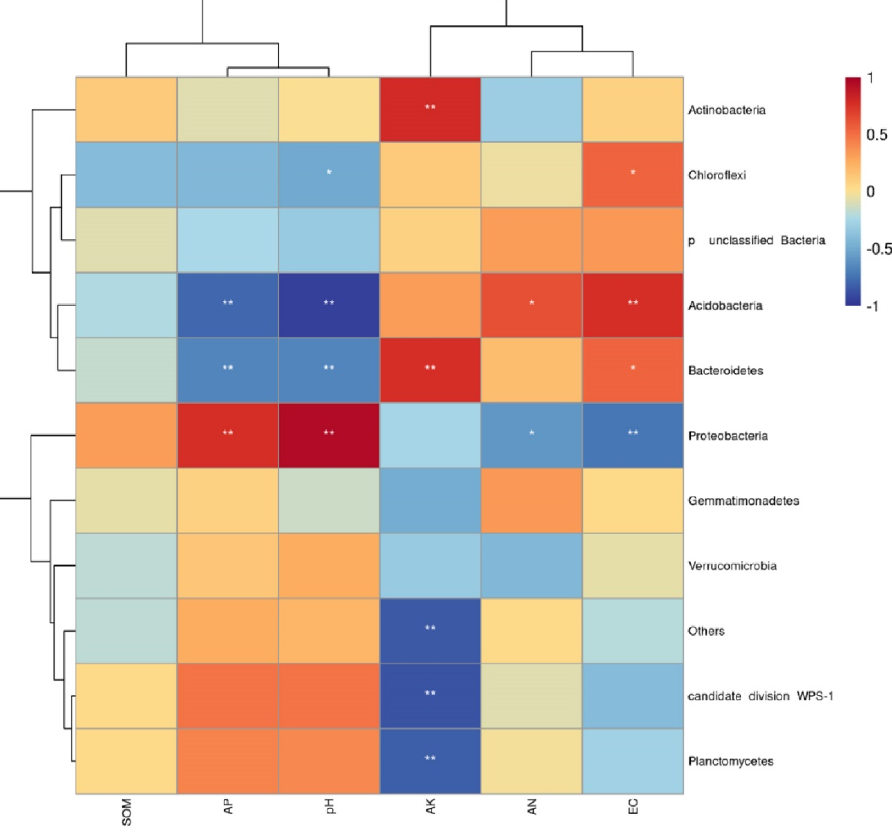
Figure 7. Correlations between the 10 dominant bacterial phyla and soil properties. * p < 0.05; ** p < 0.01. EC, electrical conductivity; SOM, soil organic matter; AN, available nitrogen; AP, available phosphorus; AK, available potassium. phosphorus; AK, available